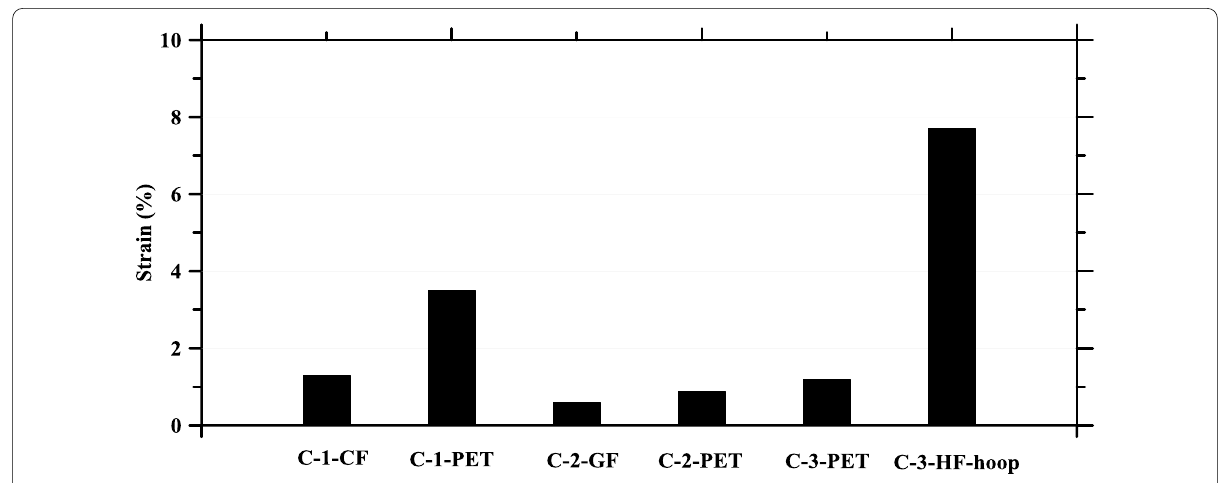
Fig. 12 Fiber strain (hoop strain of extreme compression fiber).